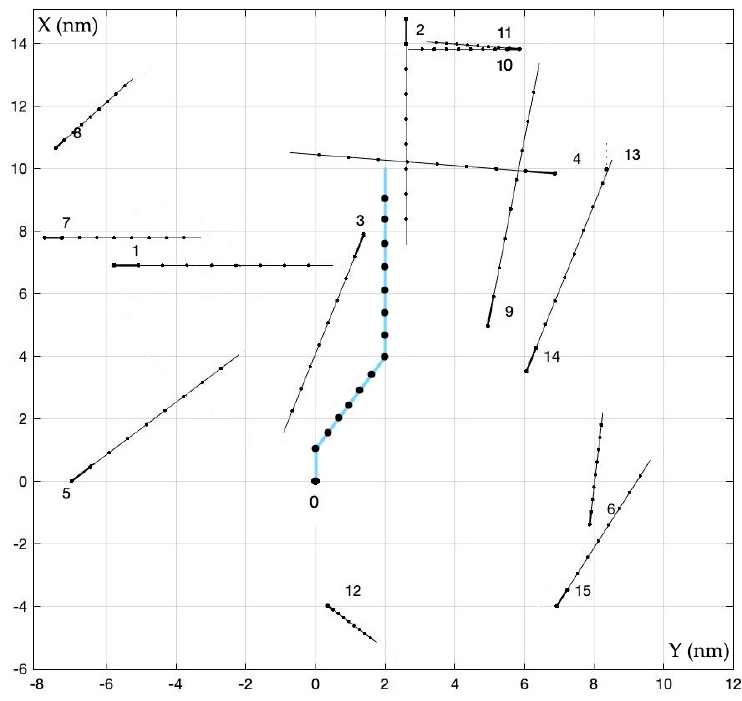
Figure 10. Trajectories of ships in non ‐ game positional control ANGPC.